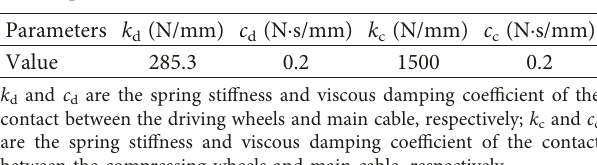
each mean wind speed interval was calculated, as shown in Figure 7. The lognormal probability density distribution, which is extensively used to fit the wind speed distribution